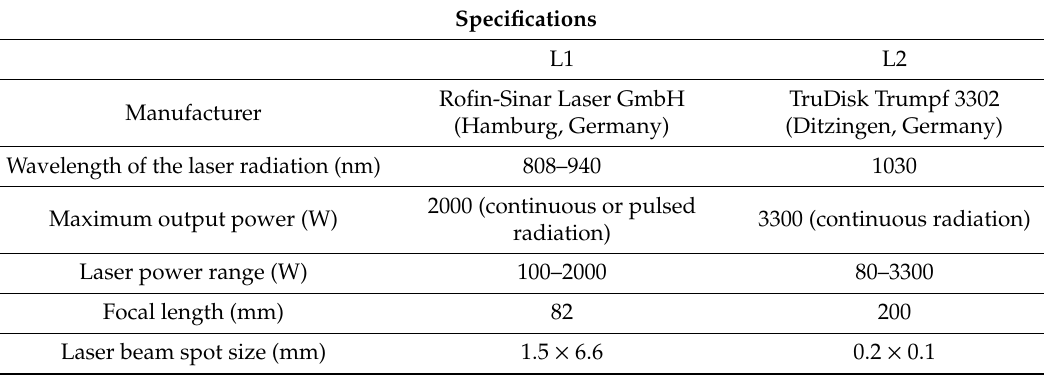
Table 1. Laser sources used. Table 2. Processing parameters for copper oxide